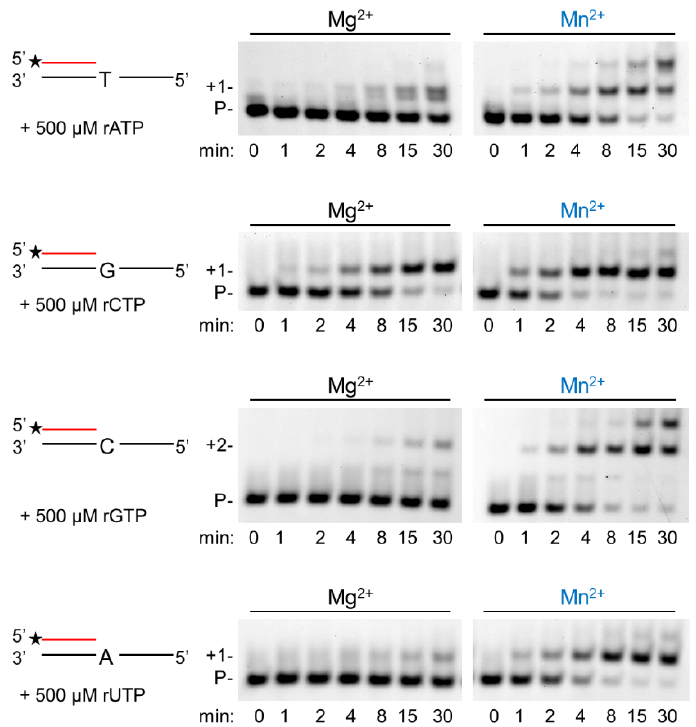
Figure 3. Manganese enhances the velocity of the polymerization reaction. Primer extension reactions were performed with 5 nM hPol η , 20 nM RNA/DNA, 500 µ M of individual rNTPs, and 4 mM Mg 2+ or Mn 2+ for the indicated times. Labels are the same as in Figure 1. Table 1. Kinetic parameters of RNA extension with rNTPs by hPol η using Mg 2+ or Mn 2+ as